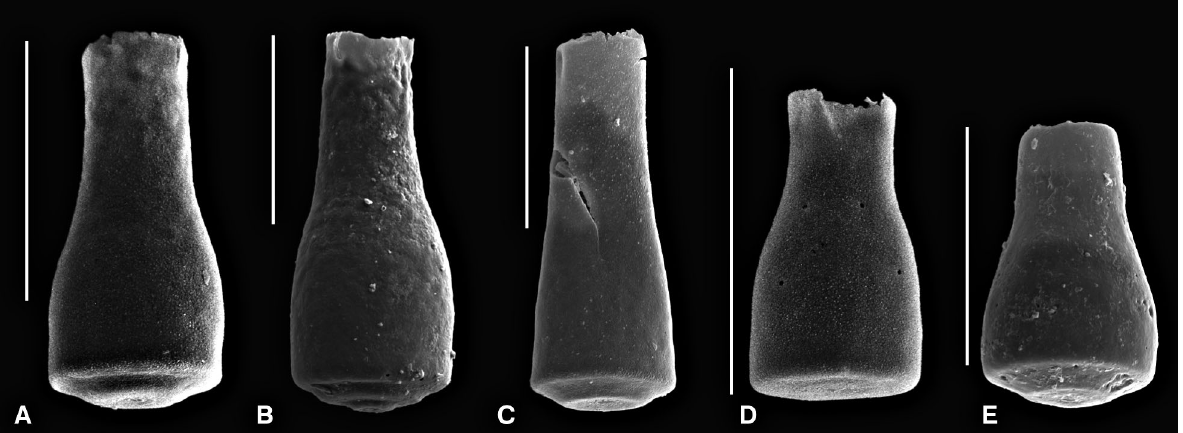
Fig. 2. Conochitina savalaensis sp. nov. A , holotype, GIT 660-1666, Viljandi: 373.8 m (140  67  40 µm); B , GIT 718-1, Viki: 342.7–342.8 m (202  86  47 µm); C , specimen with faintly developed flexure, GIT 718-2, Vihterpalu (1103): 34.3–34.4 m (201  79  47 µm); D , smallest specimen, GIT 660-1440, Rapla: 166.5 m (92  54  34 µm); E , GIT 718-3, Saare (K-20): 110.0–110.1 m (116  74  37 µm). The scale bars correspond to 100